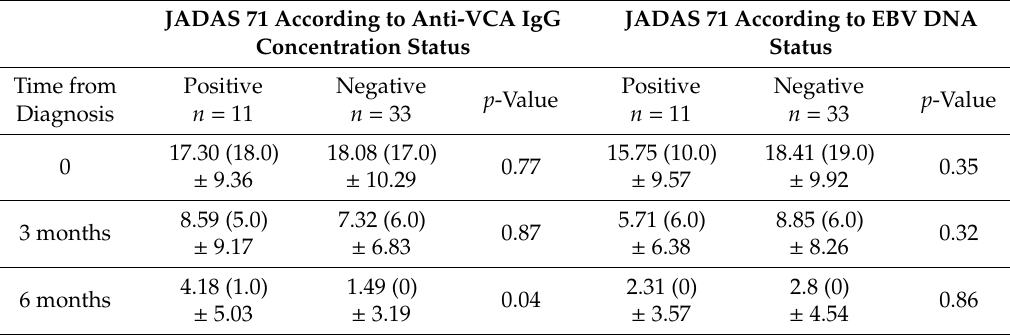
Table 6. Comparison of disease activity (JADAS 71) in JIA patients according to anti-VCA IgG concentration (positive > 1.1 vs. negative ≤ 1.1 U / mL) and EBV DNA results at the time of diagnosis and after 3 and 6 months. Results are presented as mean (median) ± standard deviation.